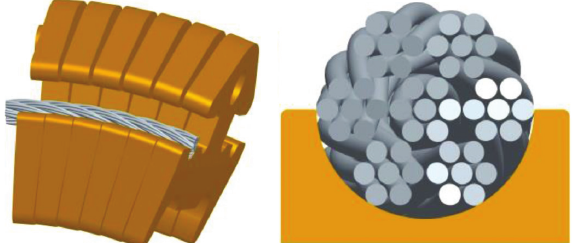
Figure 8: 2/3 lay length wire rope and metal block assembly model.